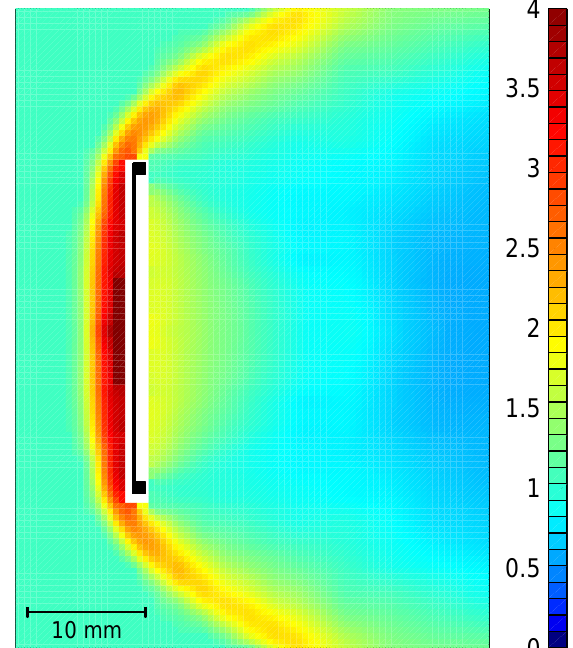
Fig. 2. Density field N/N ∞ measured around the mesh in the wind tunnel. Freestream conditions are p ∞ = 2 . 6 Pa, c ∞ = 678 ms − 1 and T ∞ = 71 K, which corresponds to a molecular mean free path of 0.62 mm. No data was obtained close to the mesh